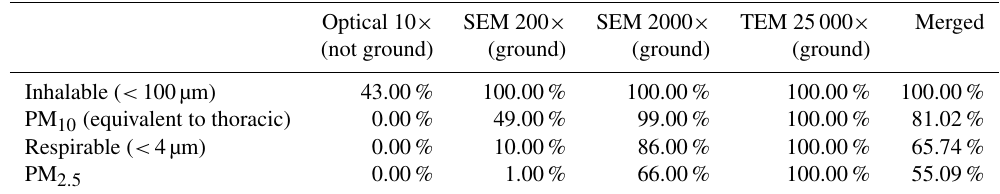
Table 5. Percentage of particles that belong to a specific particle-size category based on their D ae , which was determined by using different microscopy imaging techniques.